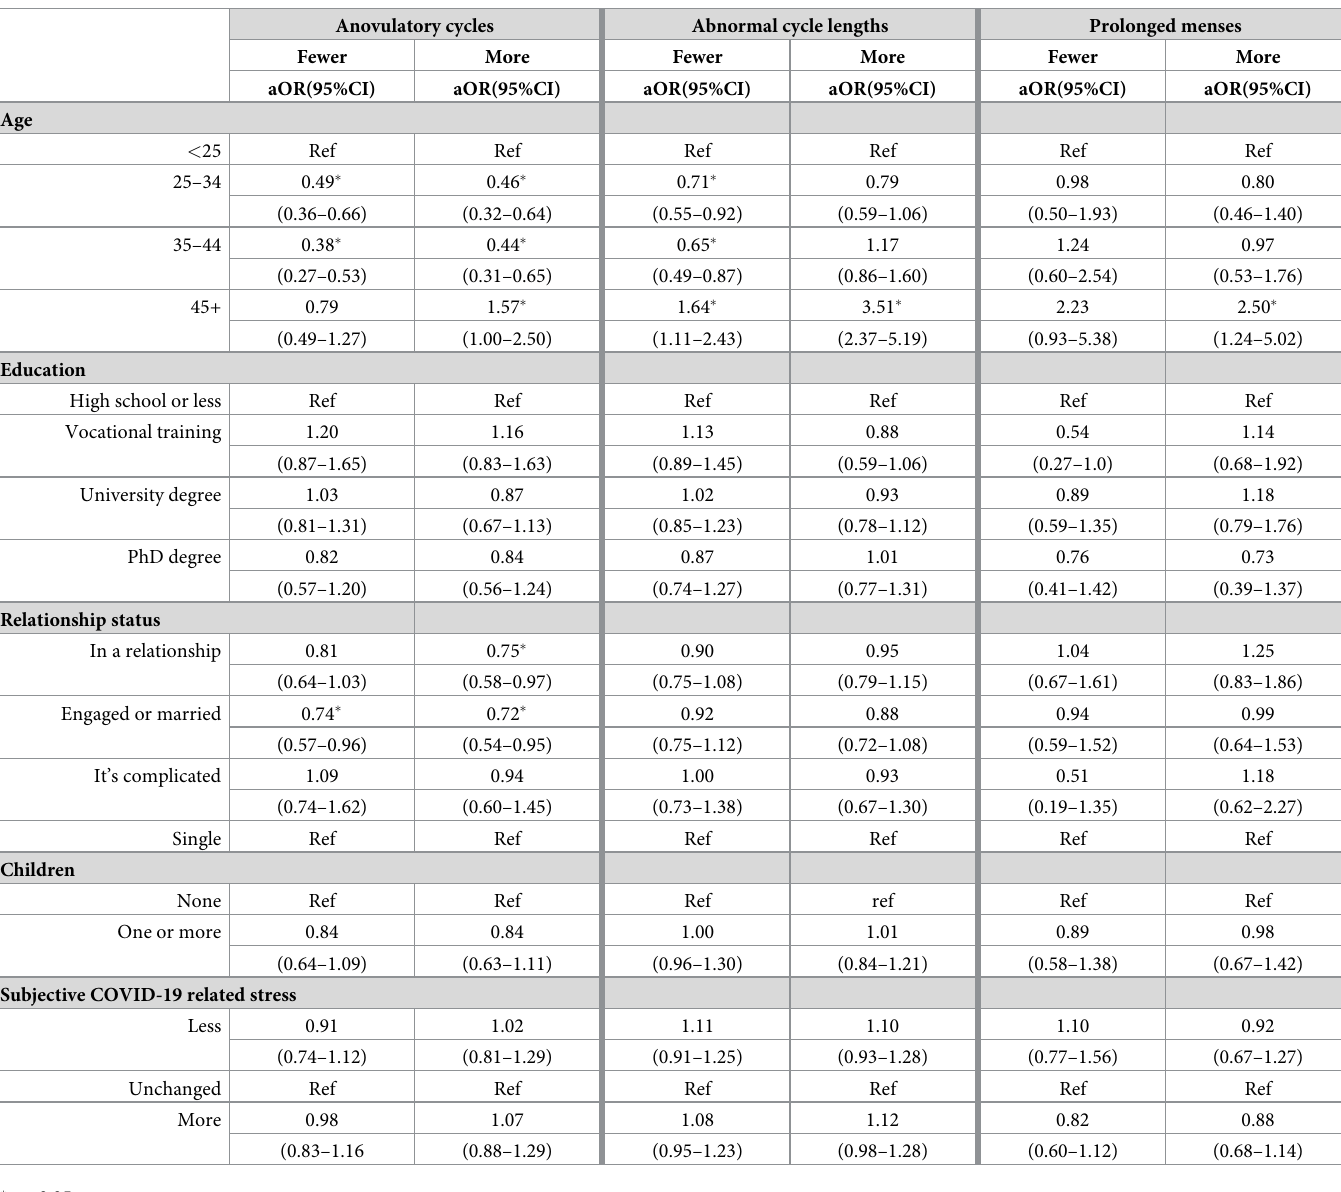
Table 4. Factors linked to more versus fewer cycle abnormalities during the COVID-19 pandemic (n = 18,076 users; N = 214,426